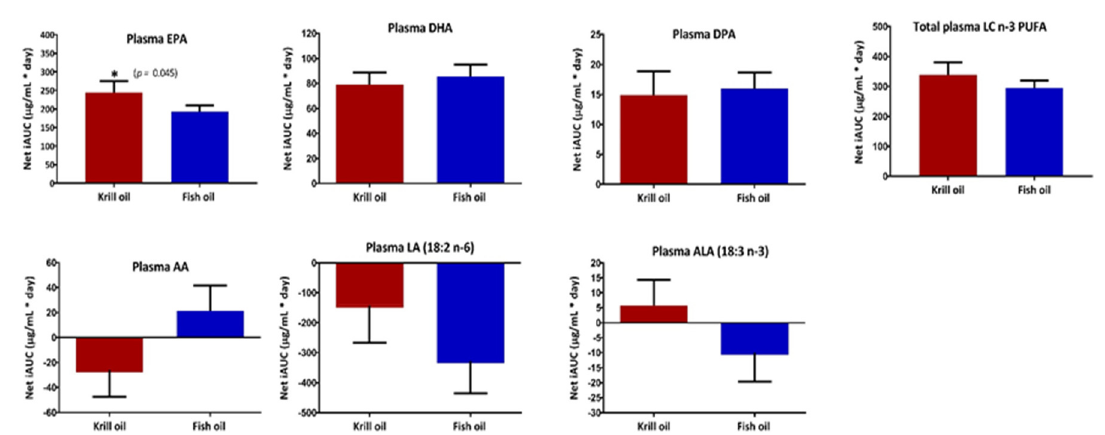
Figure 2. Relative AUCs of plasma LC omega-3 PUFA over the 30-day supplementations of KO and FO. Values are expressed as mean ± SEM. relAUC ( µ g / mL*day) from day zero to 30 ( n = 11) of plasma fatty acids was calculated using the trapezoid rule and compared between the two supplementation groups using a paired t -test. p values are represented as * p < 0.05. Abbreviation: AA, arachidonic acid; ALA, alpha-linolenic acid; net relAUC, the incremental area under the curve from baseline to 30 days; EPA, eicosapentaenoic acid; DHA, docosahexaenoic acid; DPA, docosapentaenoic acid; LC n-3 PUFA, long-chain omega-3 polyunsaturated fatty acids; LA, linoleic acid.